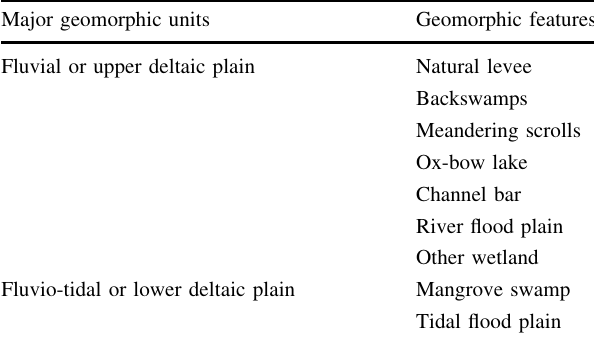
Table 1 Geomorphic units of the study